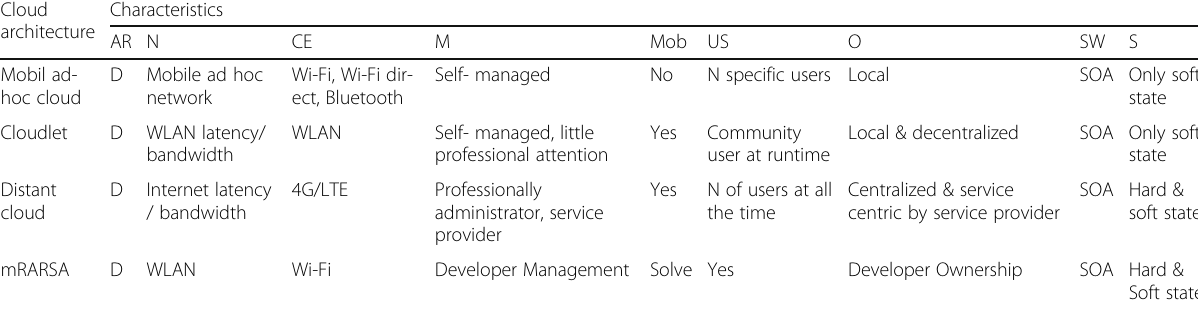
Table 2 Architectures ’ characteristic matrix Cloud architecture